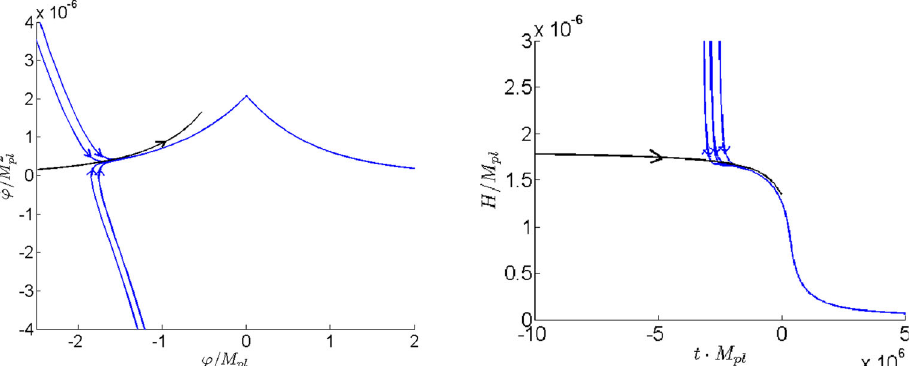
) (left) for some orbits, with the slow-roll one represented in black. Evolution of H / M pl